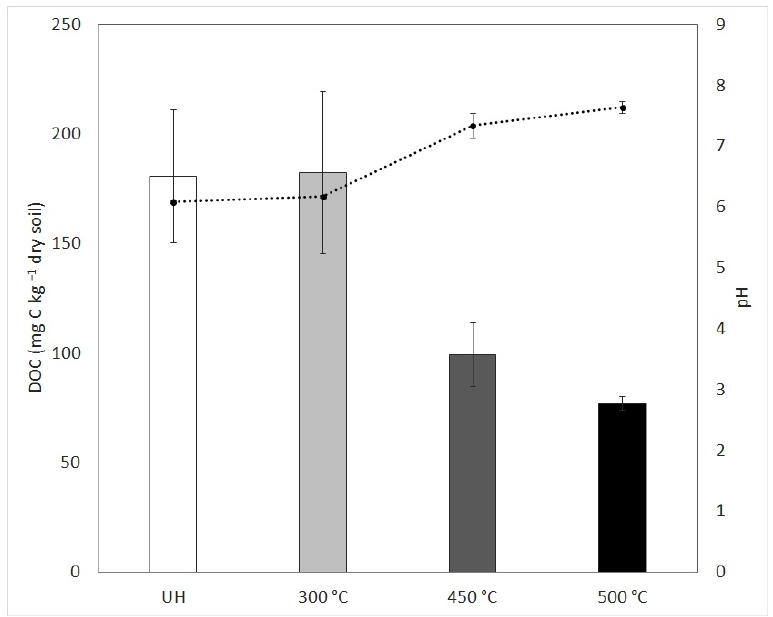
Figure 1. Mean value (±standard error) of DOC (dissolved organic carbon mg C kg − 1 dry soil) (bars) at left axis and pH (dotted line) at right axis measured in soil:water extract 1:4 and 1:2, respectively. Table 3. Different organic compounds identified in the different samples. Cmp = Reference number for the compounds used to cite them in the text; RT = Retention Time; m/z: Main diagnostic fragments; MW = Molecular